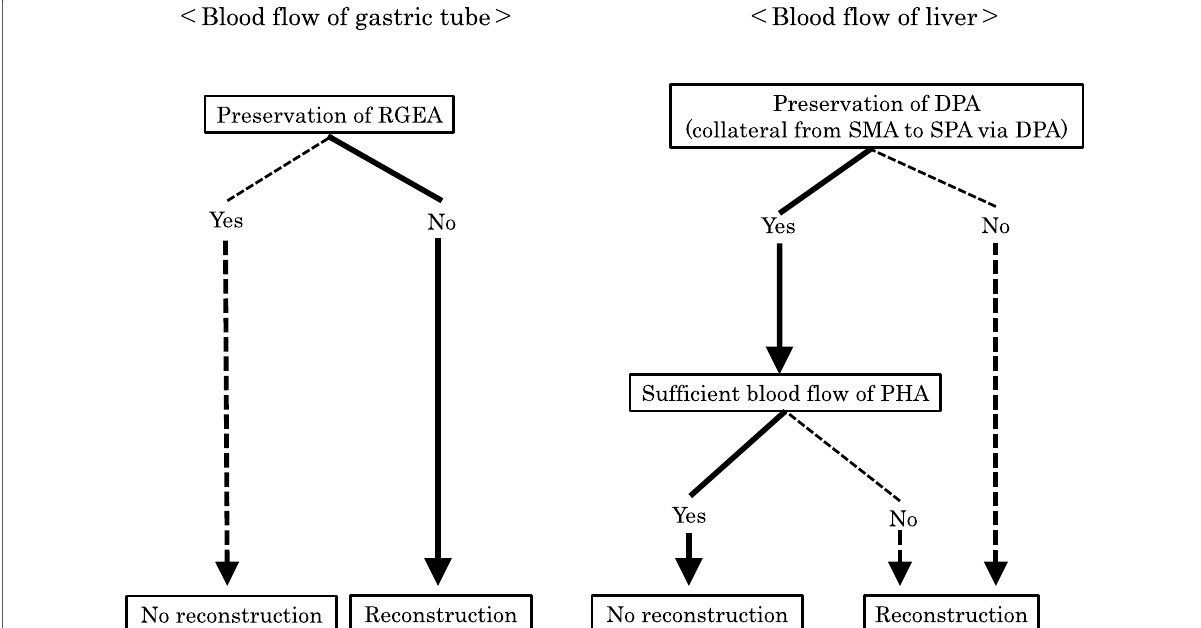
Fig. 2 Operational strategy with celiac axis stenosis after esophagectomy. The continuous line denotes the flow of the actual operation and the dotted line denotes the flow of alternative